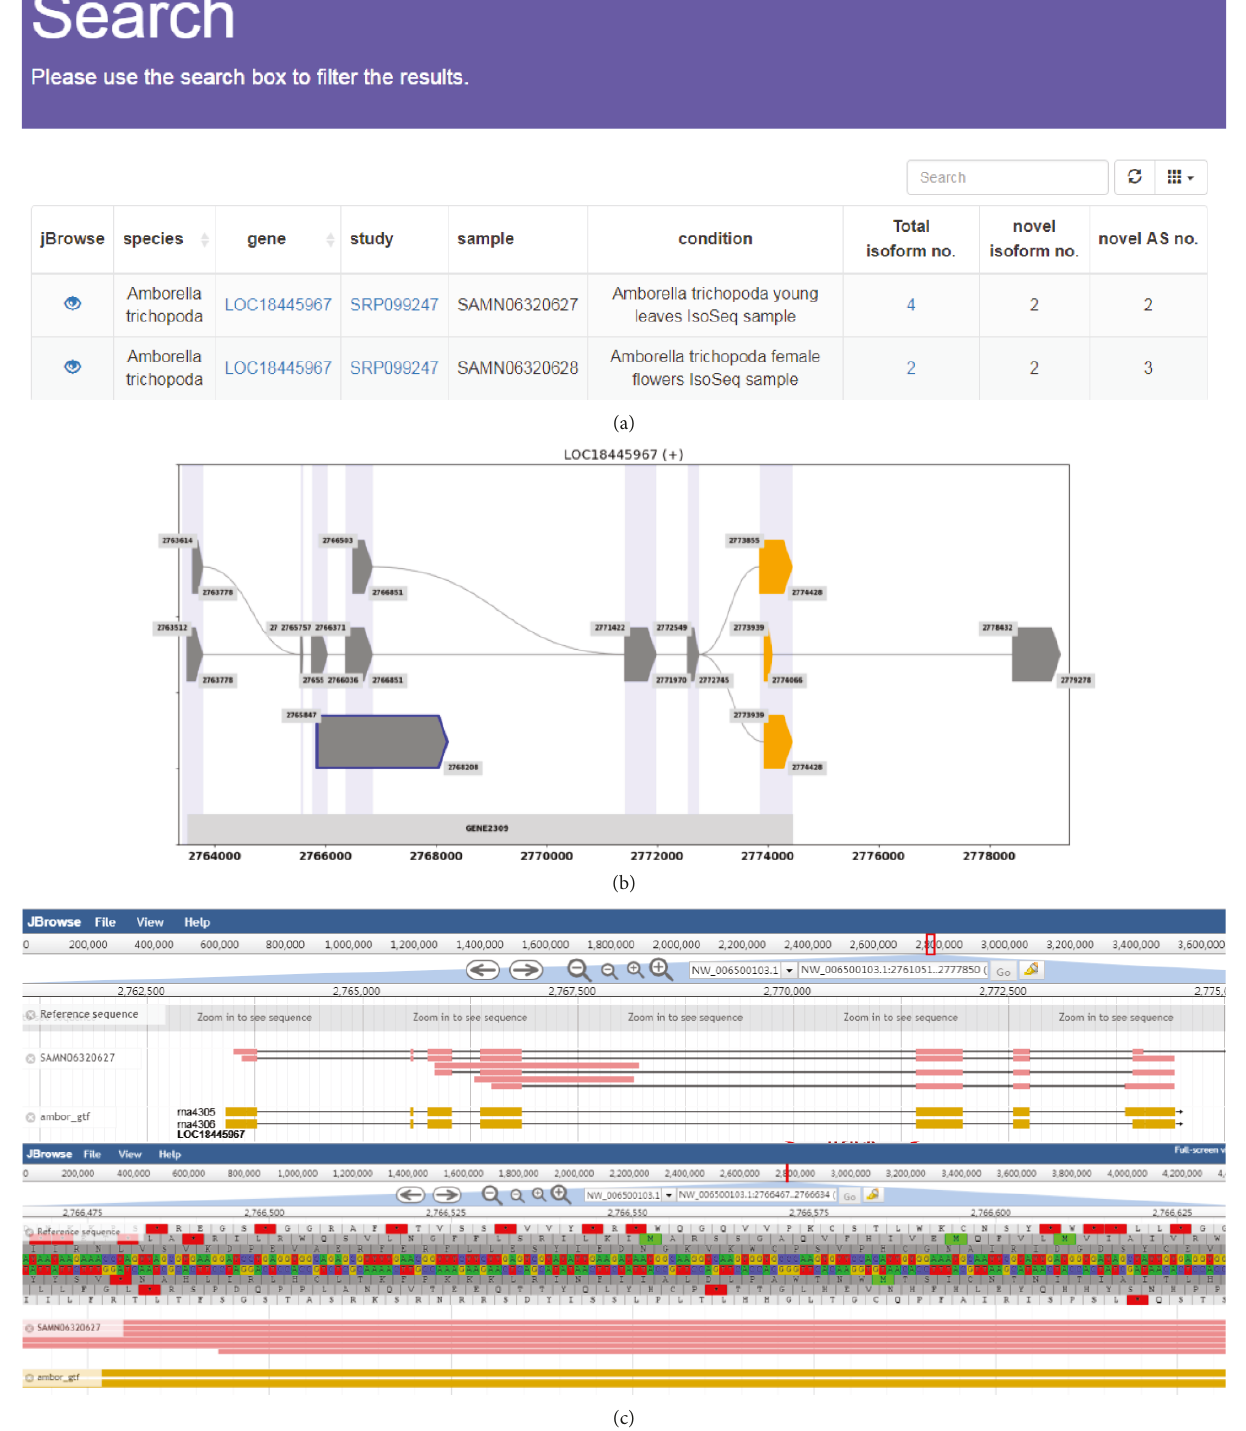
Figure 3: The gene search results from ISOdb. (a) The overview of search output, (b) the detailed diagram of total transcript isoforms (grey block: annotated exon; purple block: alternative 5 ′ event; orange block: alternative 3 ′ event; grey block with the blue border: intron retention), and (c) the genome browse of all